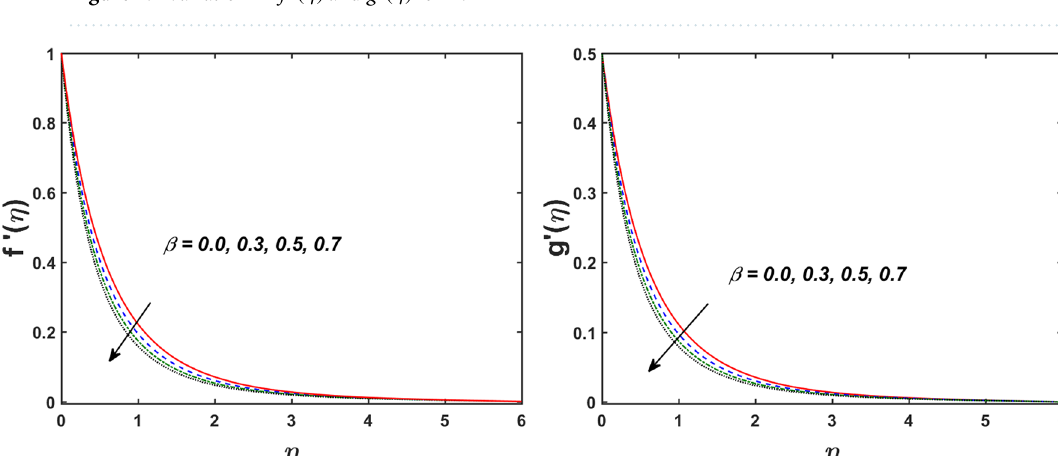
Figure 2. Variation in f ′ (η) and g ′ (η) for A .